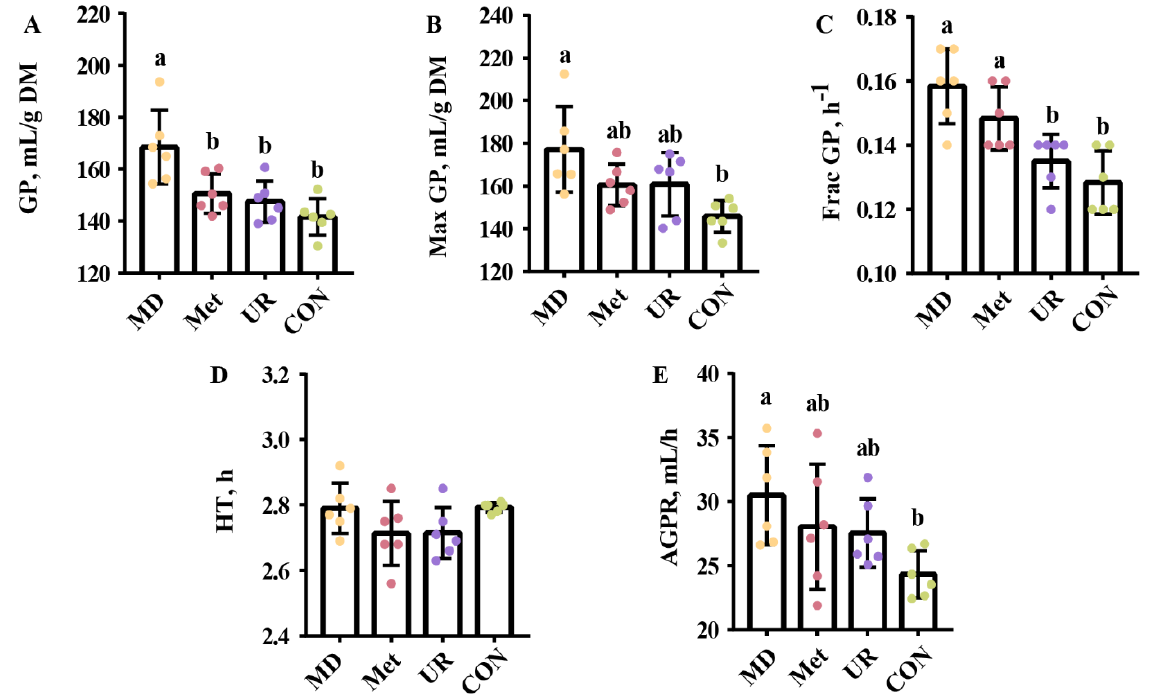
Figure 2. Effects of urea, methionine, and methionine dipeptide on parameters of in vitro fermenta- tion kinetics of total mixed ration during 48 h incubation. CON = no additive, UR = urea addition, Met = methionine addition, and MD = methionine dipeptide addition. GP ( A ) indicates cumulative gas production at 48 h. Max GP ( B ) indicates ideal maximum gas production. Frac GP. ( C ) indicates the fractional rate of gas production. HT ( D ) indicates time to reach half the ideal maximum gas production. AGPR ( E ) indicates the average gas production rate when half of the ideal maximum gas production was produced. Means with different letters (a, b) are significantly different ( p < 0.05). Vertical bars denote standard deviation (SD); n = 6 per treatment per time.